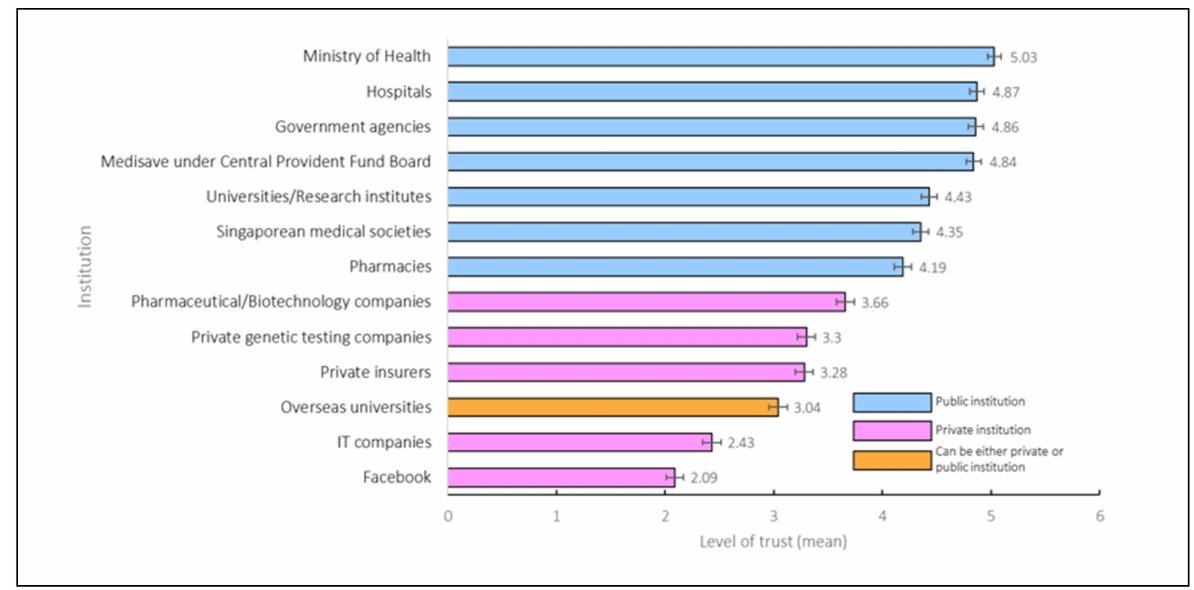
Figure 2. Mean trust scores for institutions using de-identified health data for Institutional Review Board approved research. A score of 6 represents “trust totally” and 1 represents “distrust totally”. The whiskers indicate 95% confidence